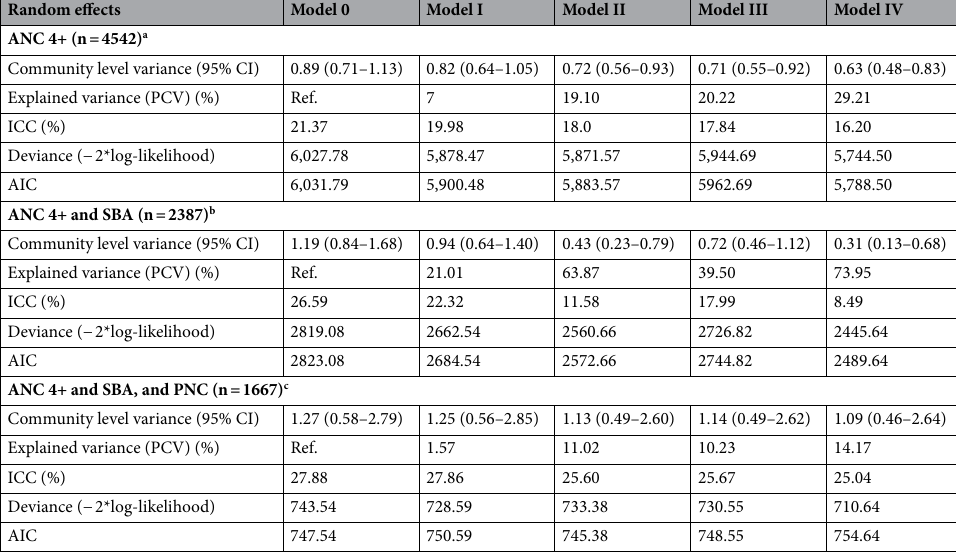
Table 3. Result from a random intercept model (a measure of variation) of CoC for maternal health: Bangladesh Demography and Health Survey 2017–2018 (n = 4942). AIC Akaike’s Information Criterion, ICC intra-class correlation coefficient, PCV proportional change in variance, Model 0 without independent variables (null model), Model 1 only individual-level variables, Model II only household-level variables, Model III only community-level variables, Model IV individual, household, and community-level variables (full model). a Analyzed the predictors of four or more ANC visits by the sample of women who took at least one ANC. b Analyzed the factors associated with the CoC from pregnancy to having SBA among sample of women who received at least four ANC visits. c Estimates the effects of predictors on the CoC from delivery to early post-delivery period among sample of women who first received at least four ANC and SBA (i.e., completion of the entire